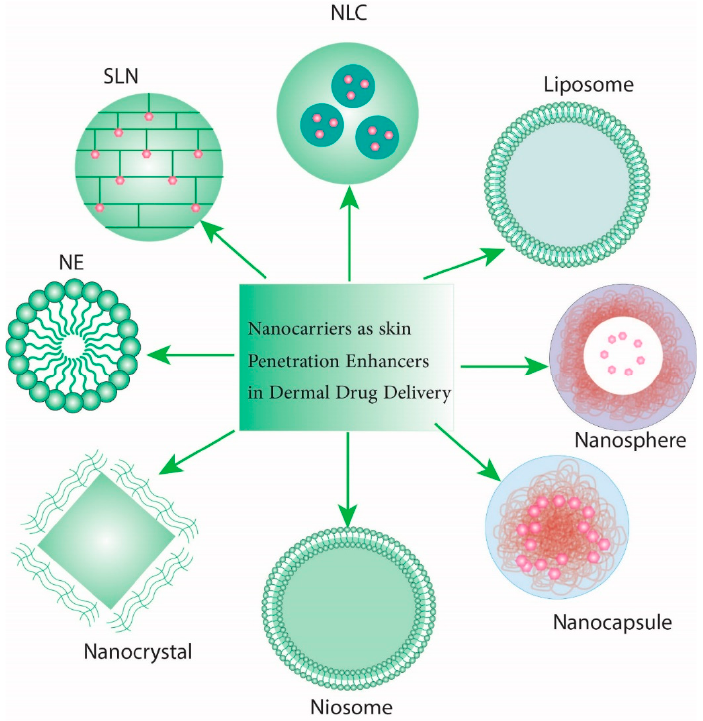
Figure 3. Nanocarriers as skin penetration enhancers in dermal drug delivery. NE: nanoemulsion, SLN: solid lipid nanoparticles, NLC: nanostructured lipid carriers.